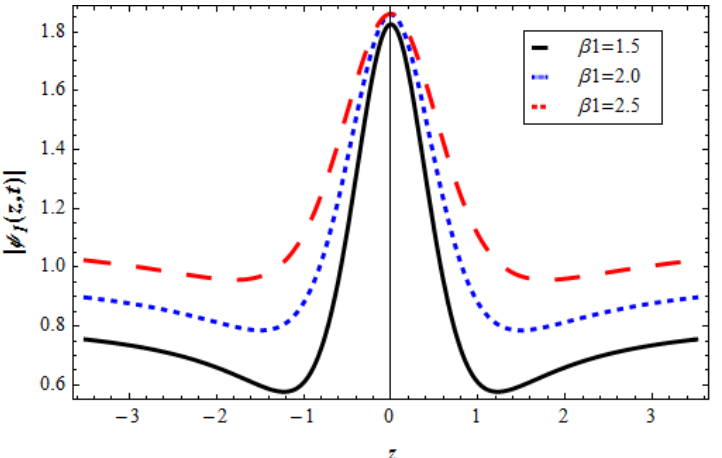
Figure 15. Change of solution (21) with z , t , β 1 for c = 0.5, v = 0.7, β 2 = 1, β 3 = 0, β 4 = 0.